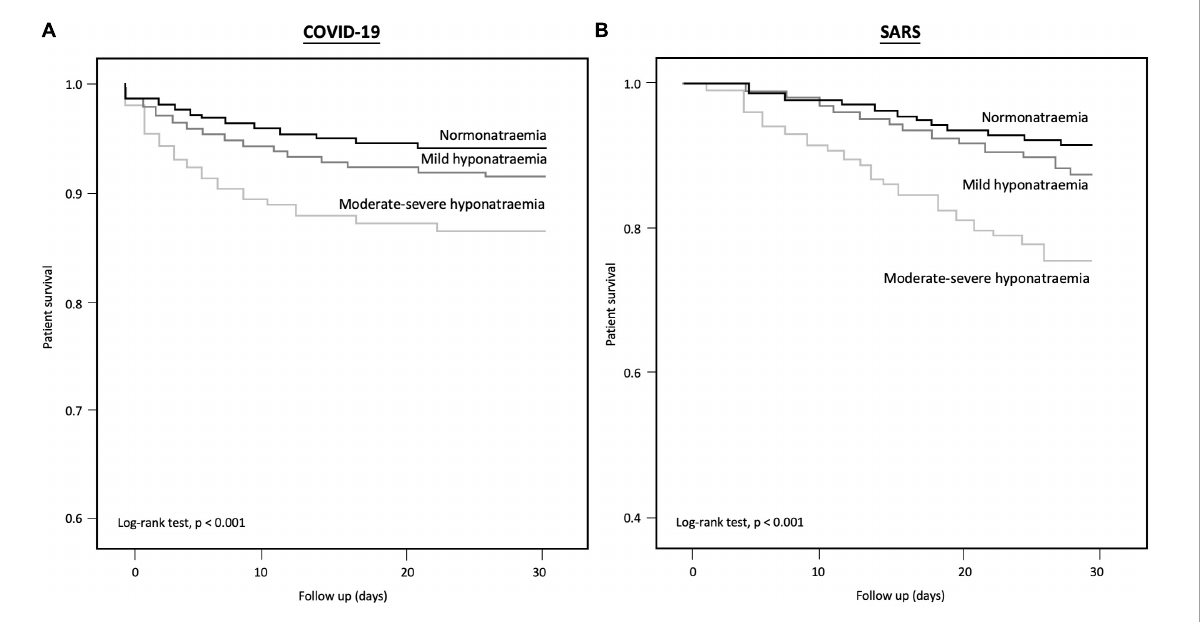
P < 0.001). The absolute rate of hyponatremia was higher in SARS patients (44.0 vs. 25.4%, P < 0.001). 132/667 (20%) of SARS patients with hyponatremia died compared to 182/849 (14.1%) of non-hyponatremic patients ( Figure 2 , P < 0.001),